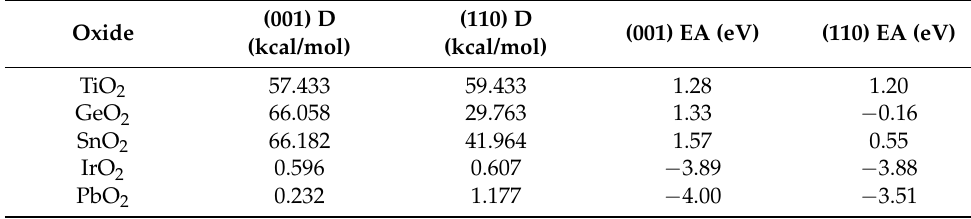
Table 4. Relative energy (D) of CO 2 species generated during adsorption; electron affinities (EA) of adsorbed CO 2 molecules. The linear CO 2 molecule display EA of − 4.19